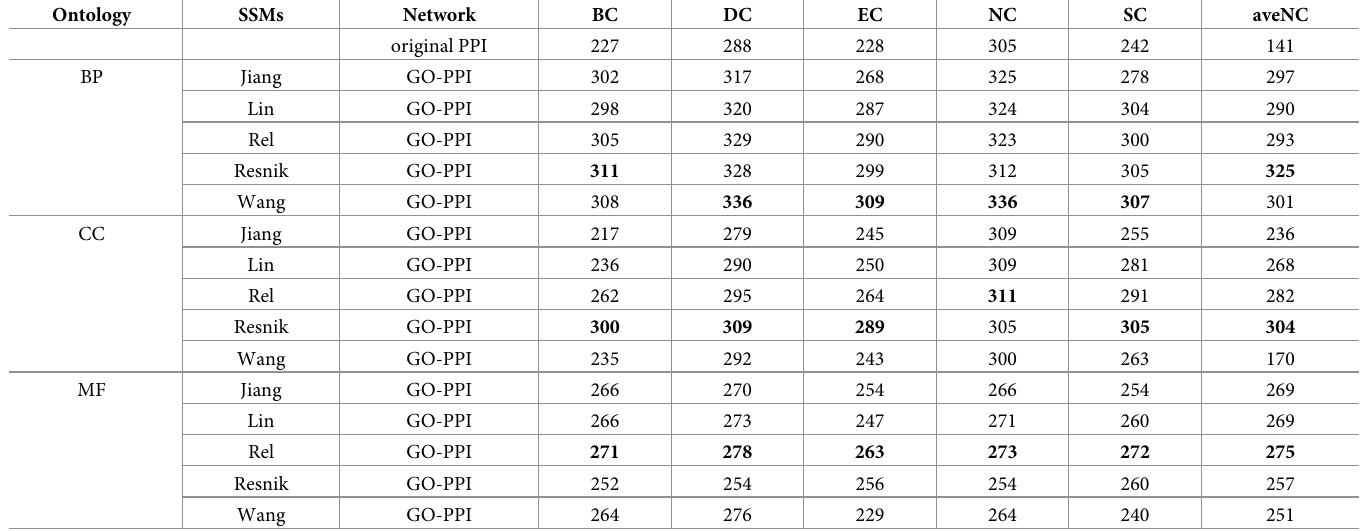
Table 6. The number of essential proteins detected by the six centrality methods under different strategies for the Krogan dataset (top 600).